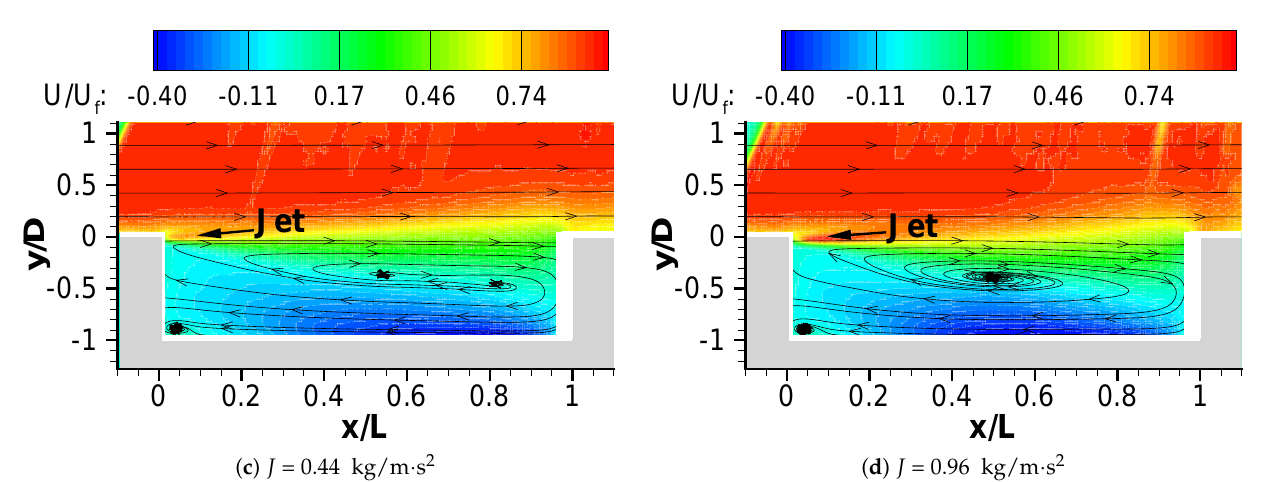
Figure 7. Contours of the time-averaged U / U f for Re D ≈ 50,000; sharp edge at LE; different J .